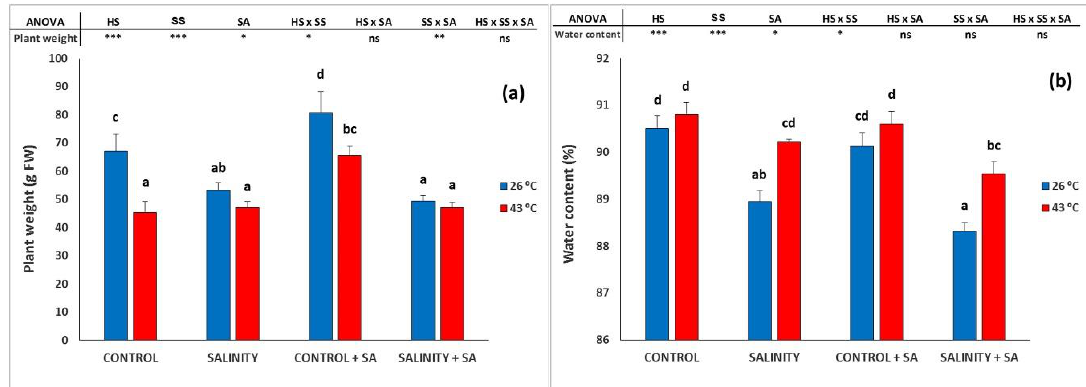
Figure 1. Effect of heat-shock and salinity, with or without salicylic acid, on the fresh weight of the aerial part (leaves and stems) of pepper plants ( a ), and on the leaf water content ( b ) in the leaves of pepper plants. The * refers to significant differences at the level of p ≤ 0.05; ** p ≤ 0.005; *** p ≤ 0.001; n.s., not significant. Different lowercase letters denote significant differences between columns, p < 0.05 HS is heat stress; SS is salinity stress; SA is salicylic acid.